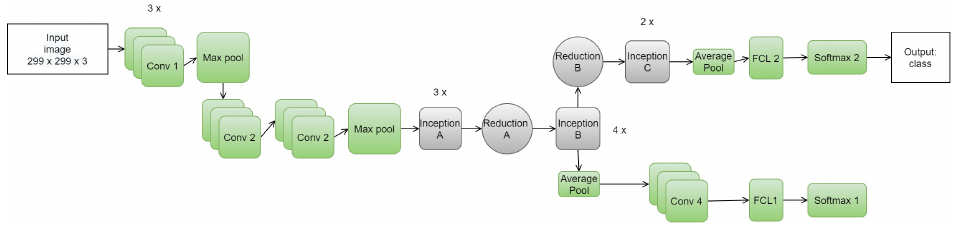
Figure 11. Inception V3 architecture.